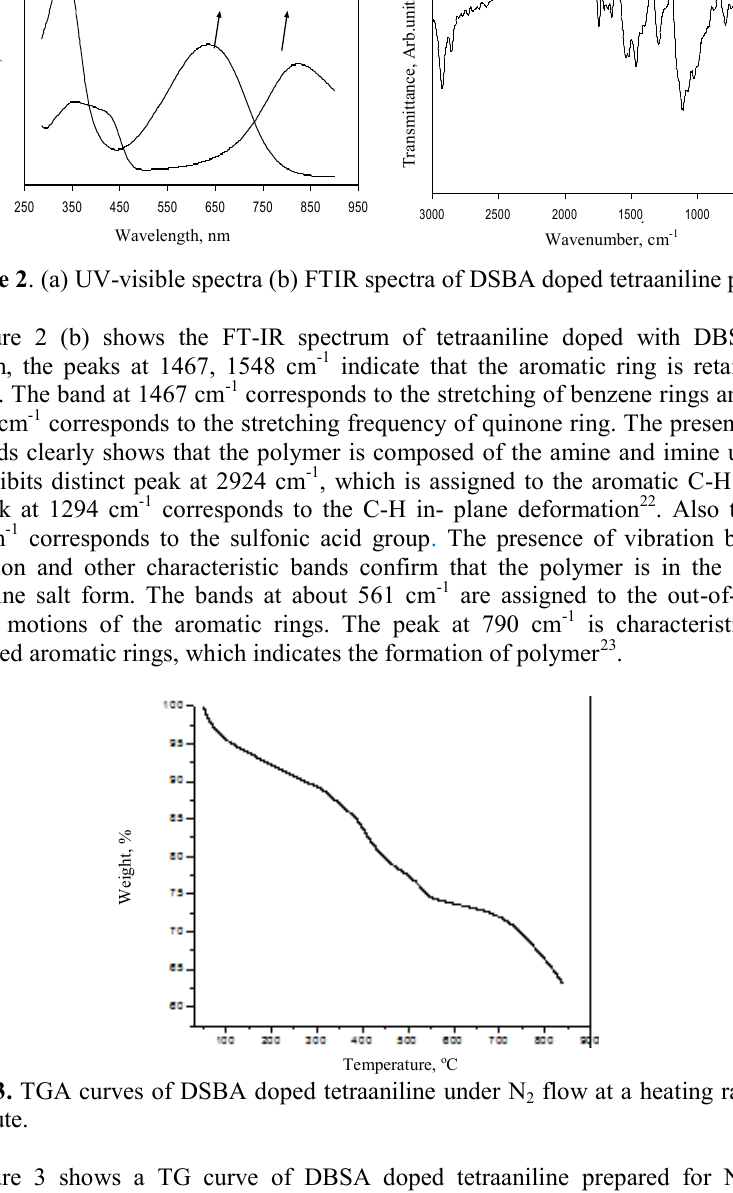
flow at a heating rate of 20 0 C 2